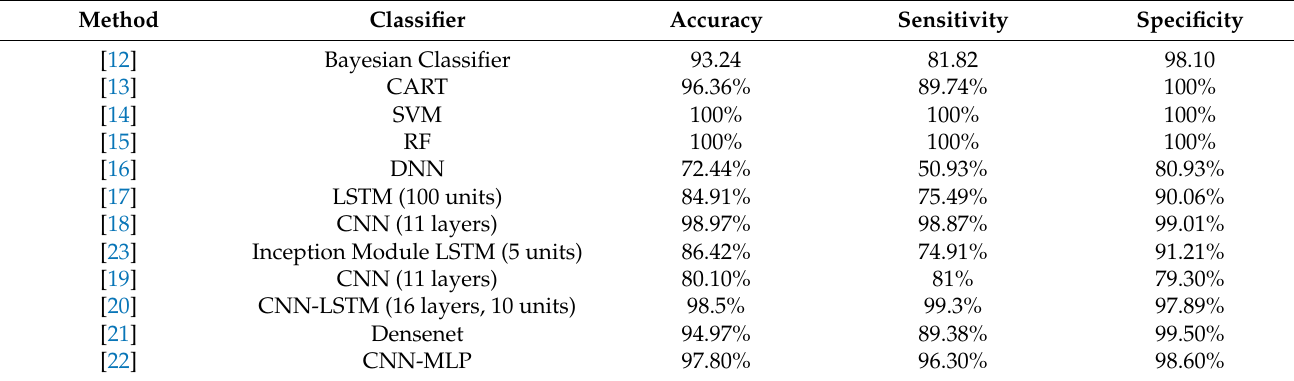
Table 1. The evaluation metrics of the different methods found in the